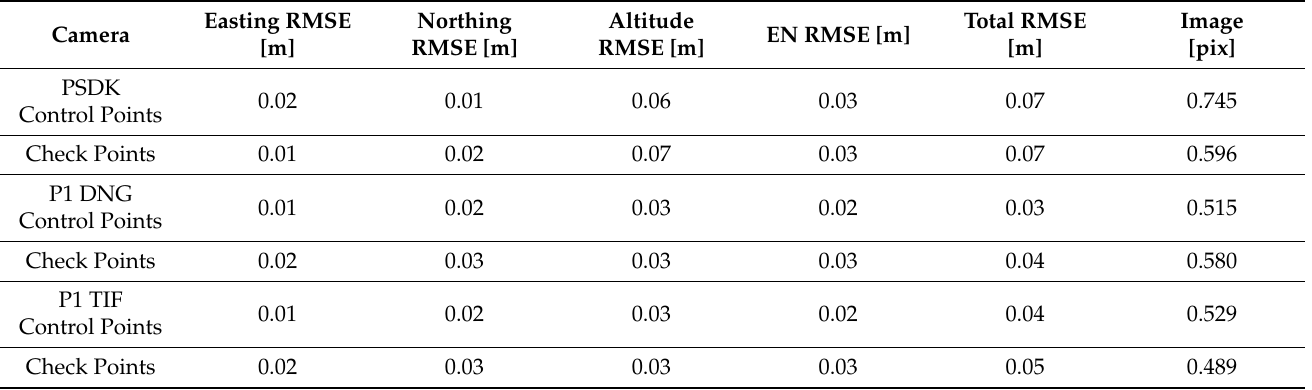
Table 5. Summary of statistical accuracy parameters for photogrammetric projects. Agisoft Metashape reports.